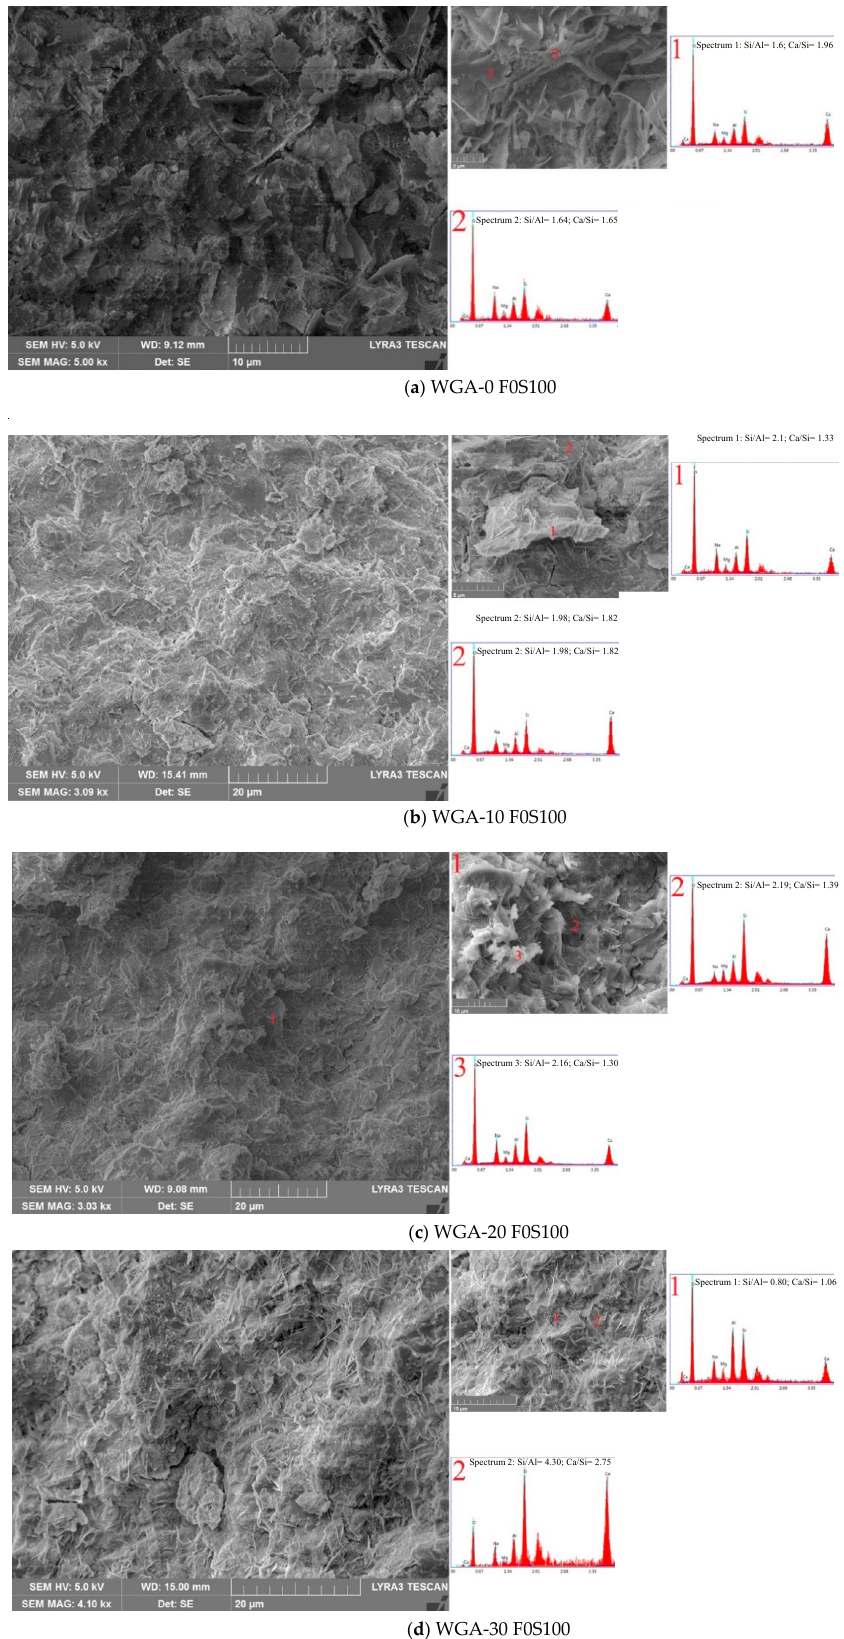
Figure 13. SEM Micrographs and EDX spectra of sample F0S100 activated in ( a ) WGA-0, ( b ) WGA-10, ( c ) WGA-20 and ( d ) WGA-30 solution.